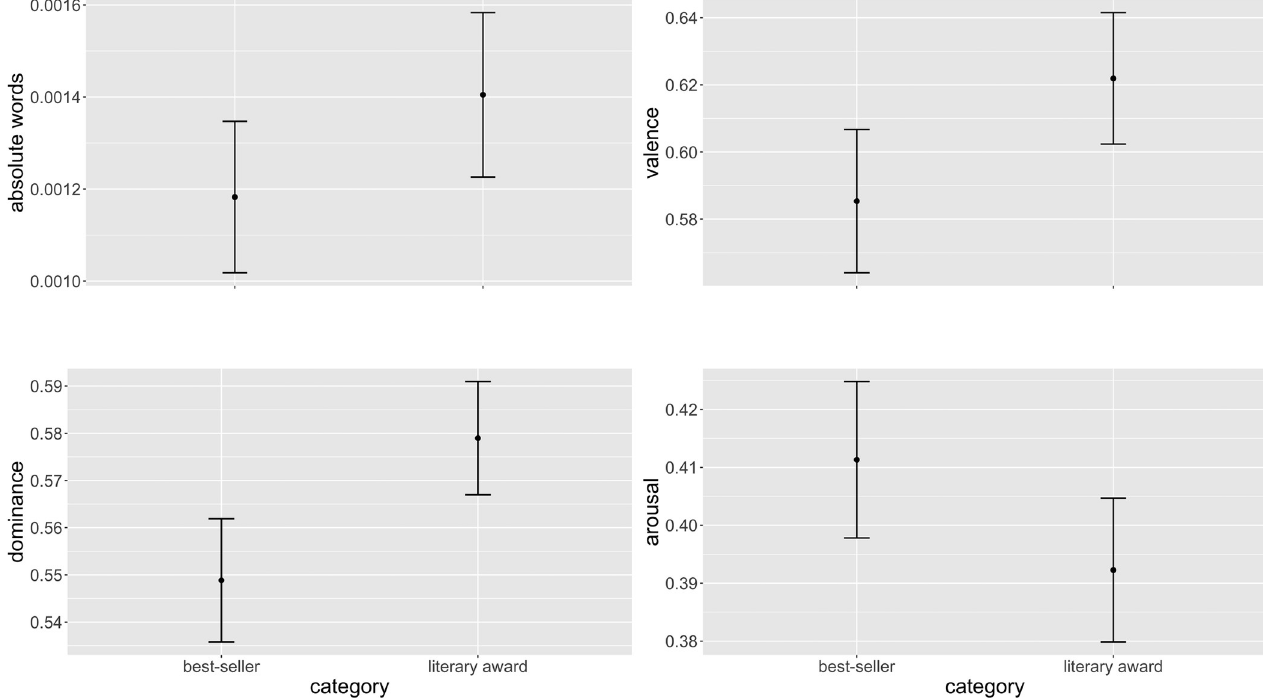
Fig 7. Predicted marginal means for the probability of absolute words, valence, dominance, and